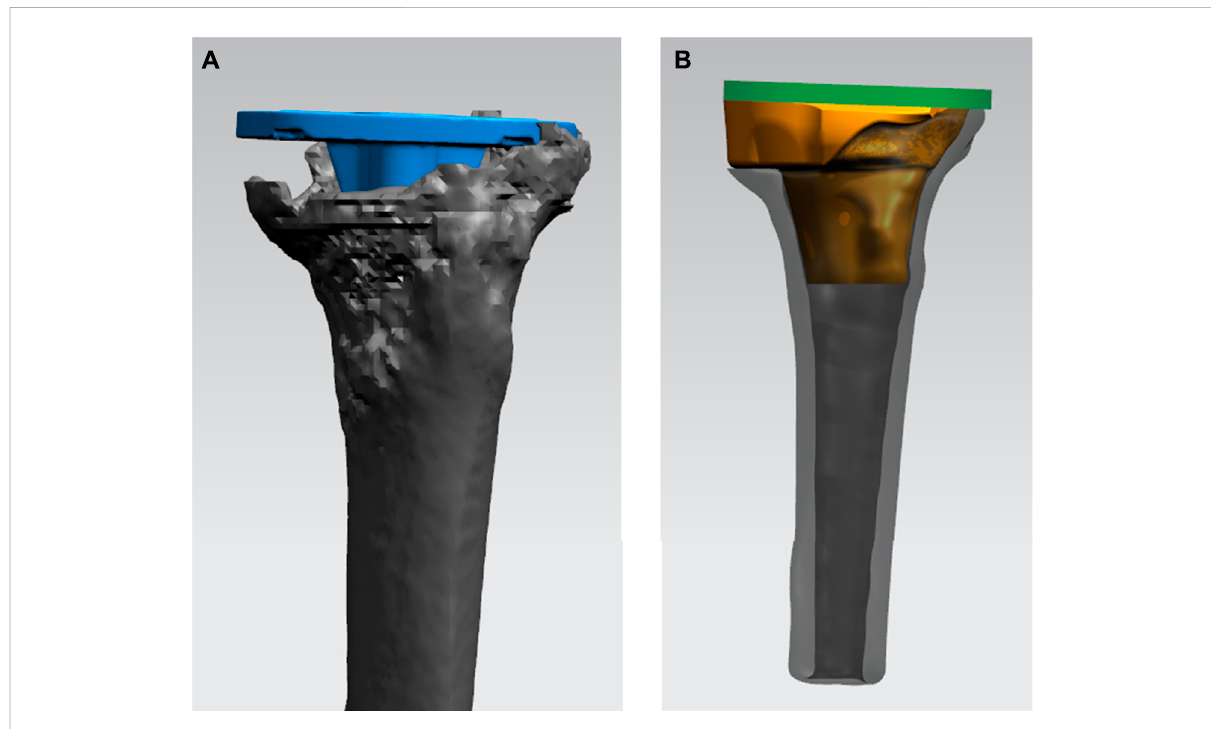
FIGURE 3 Process of designing the 3D-printed porous tantalum cone. (A) Simulating the position of the tibial tray (blue) in the tibia in TKA revision. (B) Designing the shape and size of the porous tantalum cone (yellow) conforming to the bone